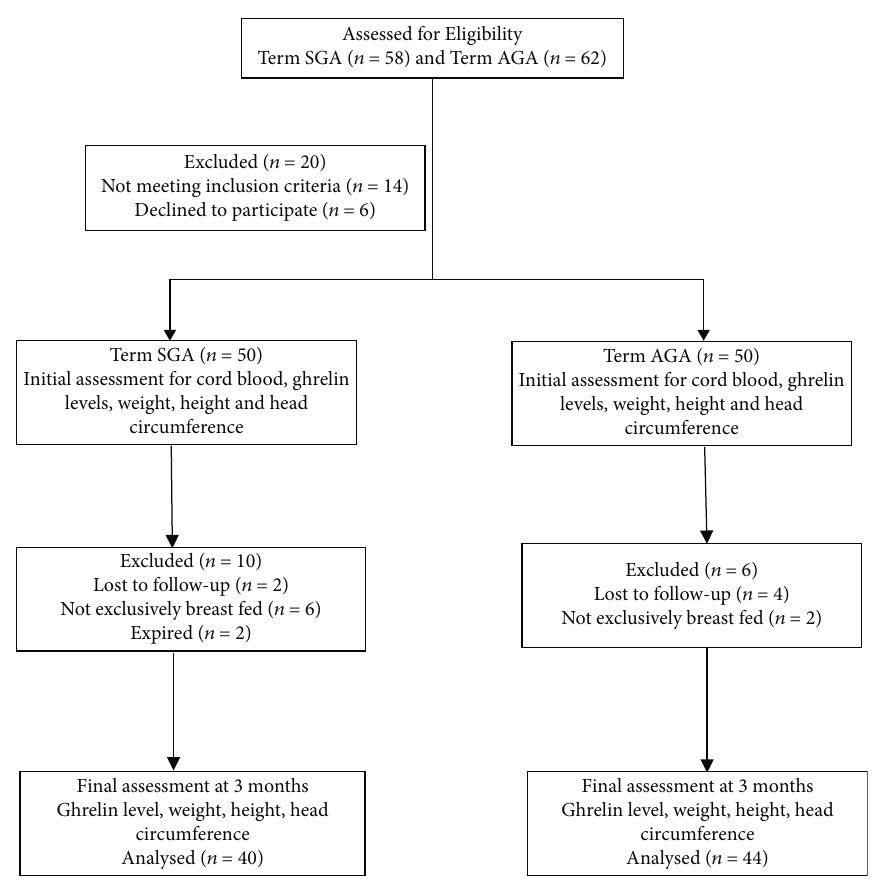
Figure 1: Flow chart of patients in the